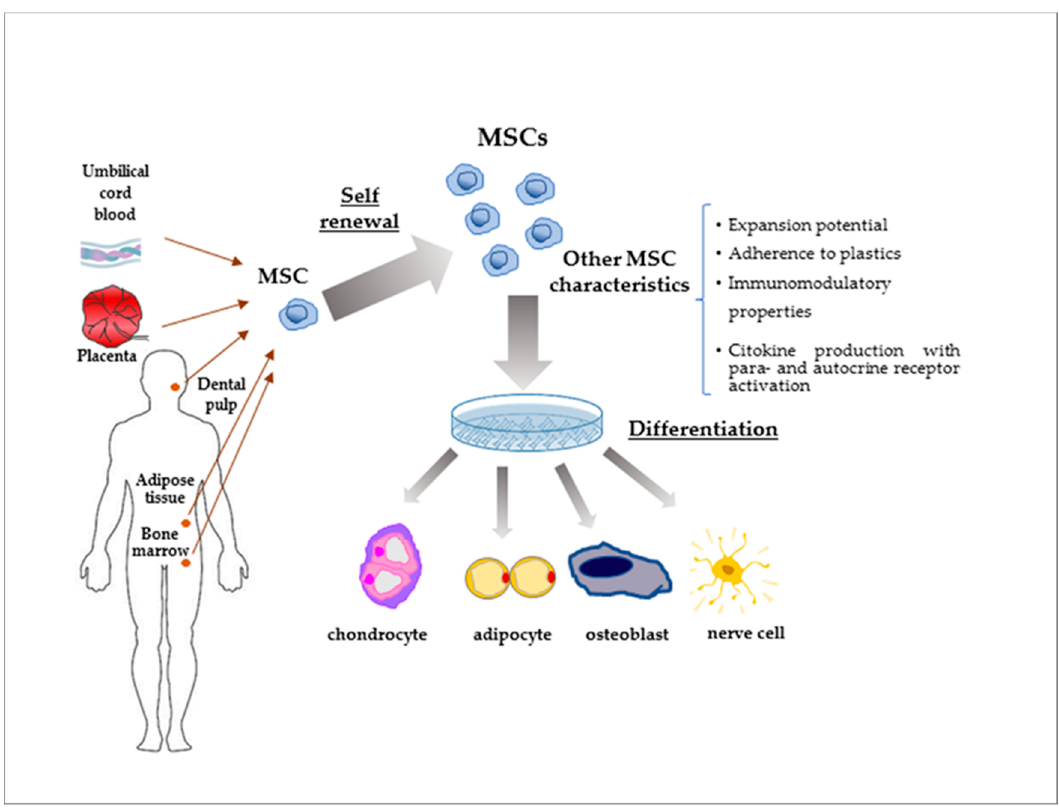
Figure 2. Main tissue origin of mesenchymal stem cell (MSCs) and their relative functions.